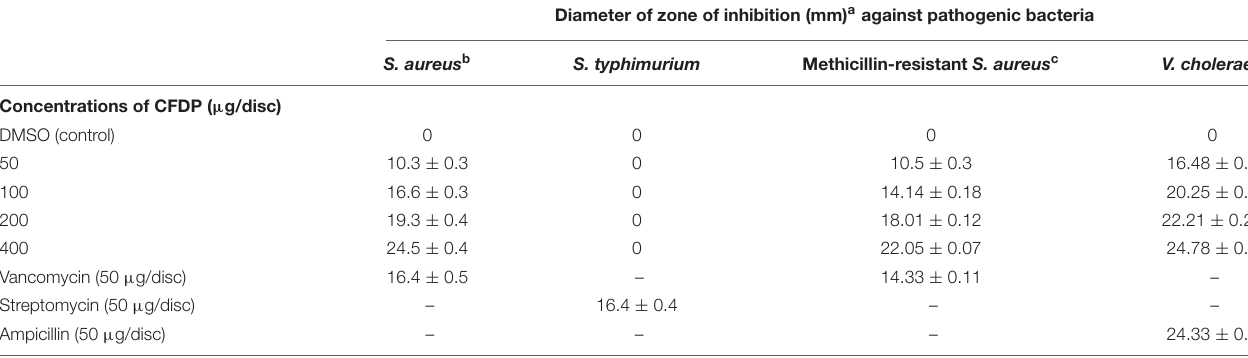
FIGURE 10 | Zones of inhibition produced by CPEF04 culture filtrate dried powder (CFDP) against Gram positive and Gram-negative pathogenic bacteria: (A) Staphylococcus aureus , (B) Salmonella typhimurium , (C) methicillin-resistant S. aureus , and (D) Vibrio cholerae . TABLE 3 | Antibacterial activity of CPEF04 culture filtrate dried powder (CFDP) [minimum inhibitory concentration (MIC) and zone of inhibition]. Diameter of zone of inhibition (mm) a against pathogenic